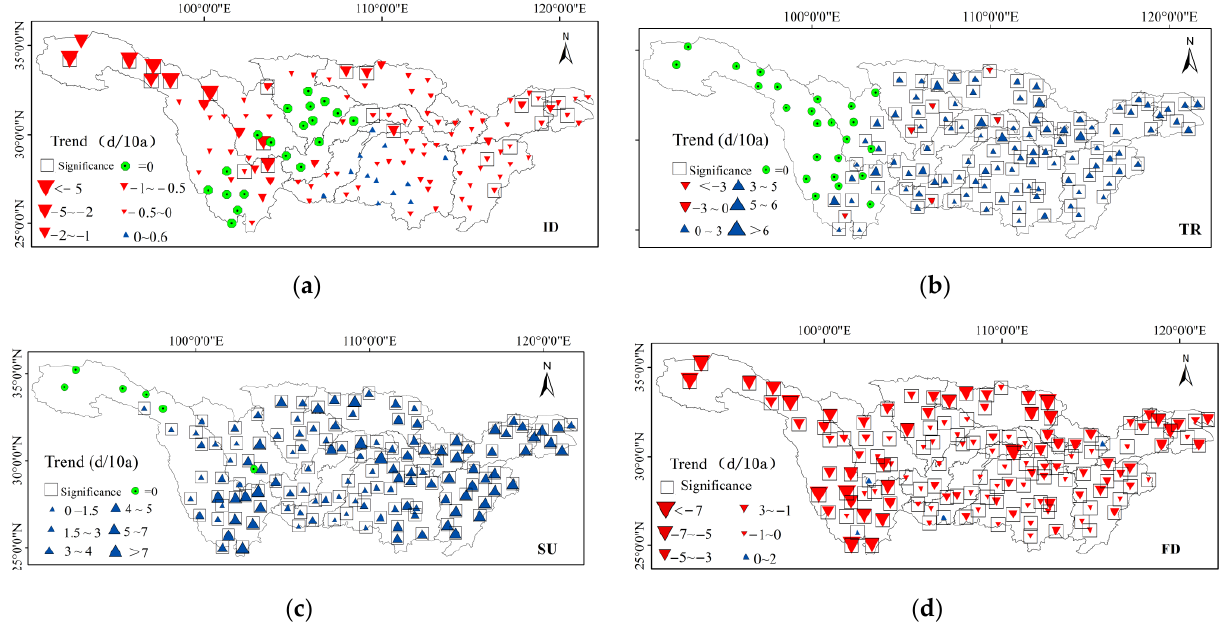
Figure 4. Temporal variation of the absolute indices of extreme temperature in the Yangtze River Basin from 1970 to 2014. ( a ) is ID, ( b ) is FD, ( c ) is SU and ( d ) is TR.